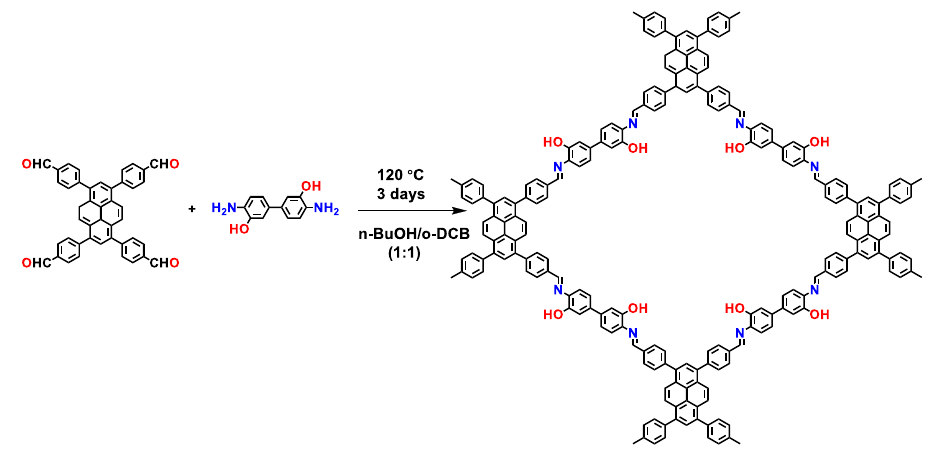
Fig. 1 Synthesis process and structure of